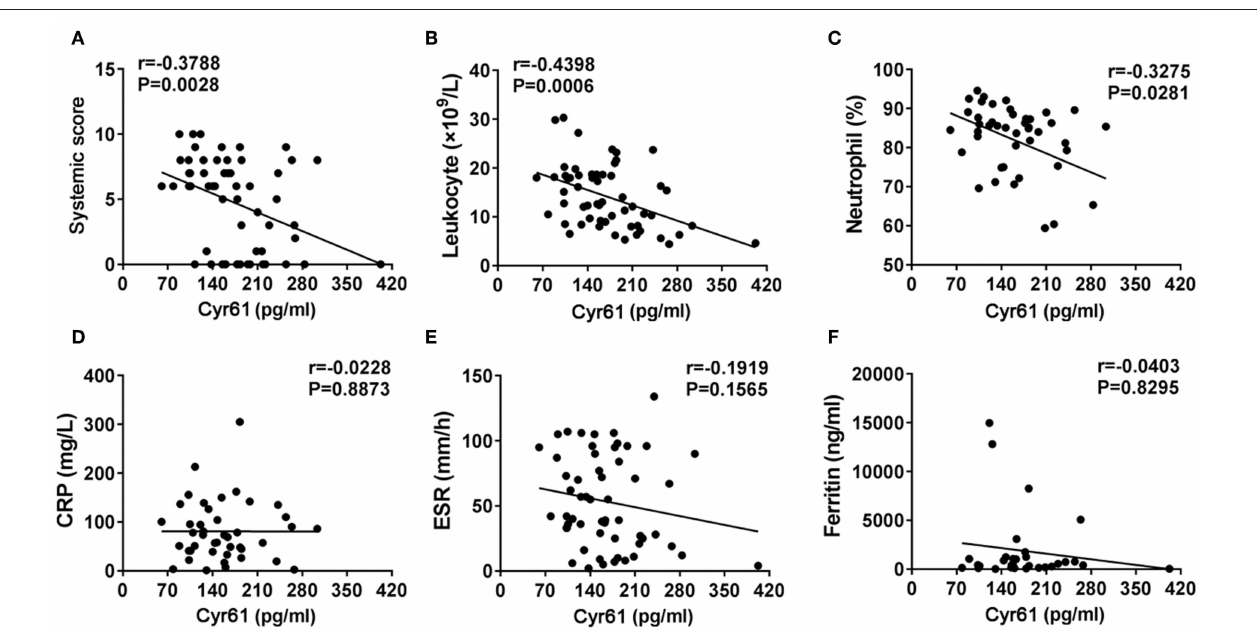
FIGURE 2 | The correlations between the serum levels of cysteine-rich angiogenic inducer 61 (Cyr61) and disease activity in adult-onset Still’s disease (AOSD) patients are shown. The correlations between serum levels of Cyr61 and systemic score (A) , the counts of leukocytes (B) and neutrophils (C) , and C-reactive protein (CRP) (D) , erythrocyte sedimentation rate (ESR) (E) , and ferritin levels (F) were analyzed by the non-parametric Spearman correlation test.